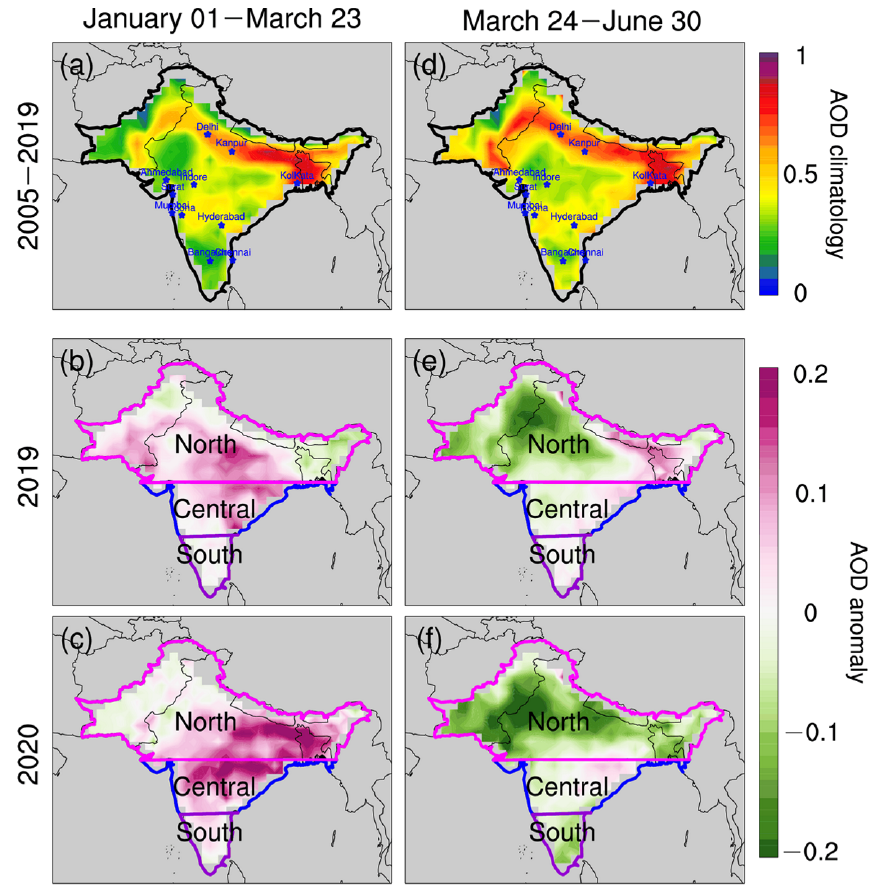
Figure 4. The same as Figure 1, but for total column AOD. Data are from MODIS.